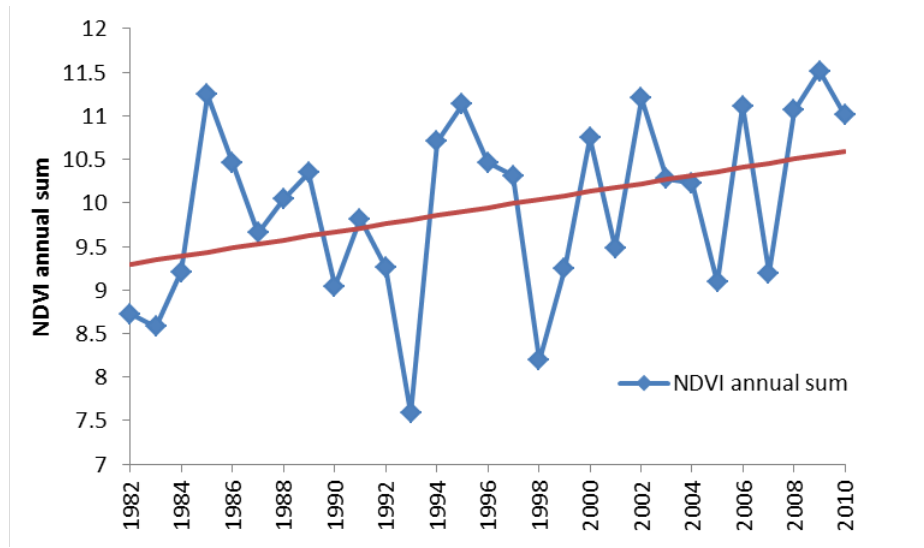
Figure 4. Mean value of annually accumulated NDVI3g data (1982–2010) for all pixels within the focus region of Serido (red line = Theil-Sen trend).